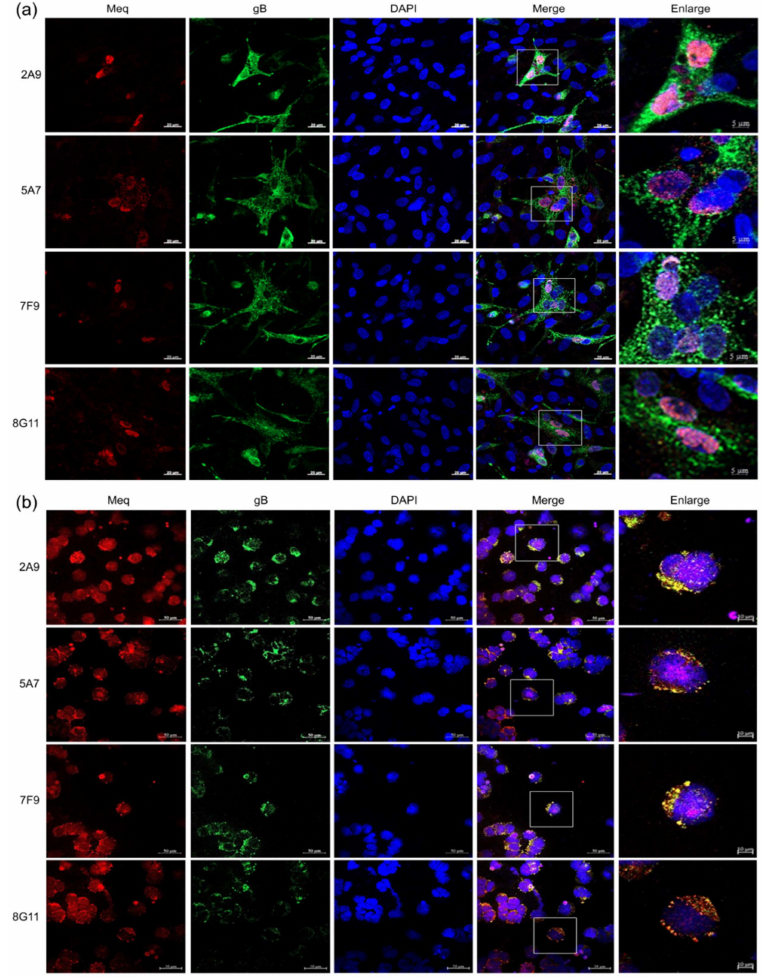
Figure 4. Confocal analysis of the Meq and gB proteins in MDV-infected CEFs and transformed MSB-1 cells. ( a ) Staining of the Meq and gB proteins in virus-infected CEF cells. The GX0101-infected CEFs were trypsinized, diluted and transferred to a special confocal culture dish. Then, the cells were fixed and incubated with Meq-specific antibodies and DyLight 594 labeled Goat Anti-Mouse IgG sequentially, followed by the incubation with anti-gB mAb HB3 and DyLight 488 labeled Goat Anti-Mouse IgG, respectively. The DAPI was used to stain and indicate the nuclei of CEF cells. Meq, MDV − 1 oncoprotein stained in red; gB, MDV − 1 glycoprotein B stained in green; DAPI, 4’,6- diamidino-2-phenylindole used to indicate the nuclei of cells in blue; Merge, merged image in purple; Enlarge, enlarged pictures from white brackets in merged images. (Scale bar = 20 µ m or 5 µ m) ( b ) Staining of the Meq and gB proteins in MSB-1 cells. The cells were adhered to the confocal special cell culture dish and the IFA staining was performed in the same way. Captions are the same as described above. (Scale bar = 50 µ m or 10 µ